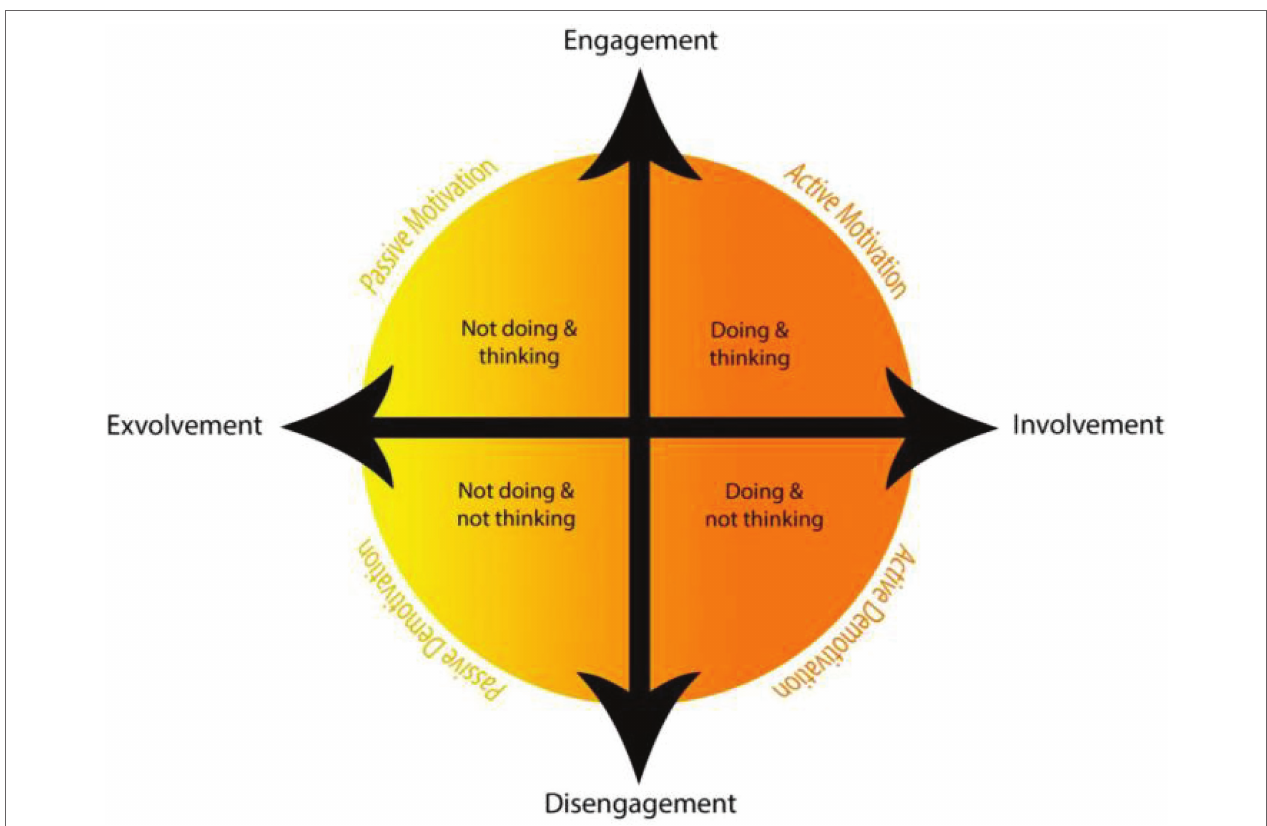
FIGURE 2 | The dual continuum model of motivation. Adapted from Pishghadam (2019, p.